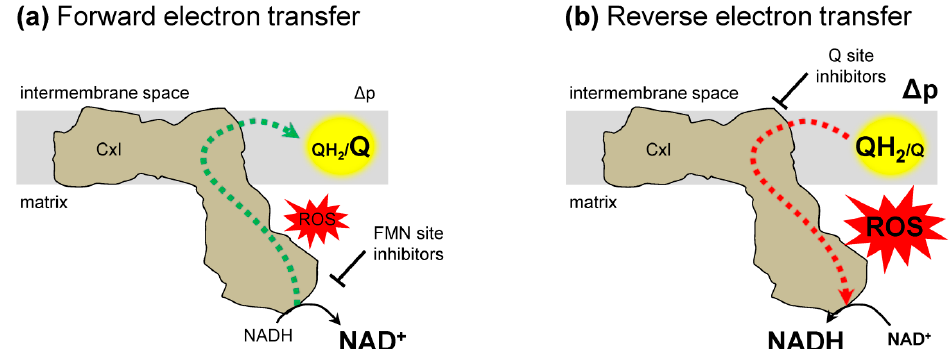
Figure 2. Complex I electron transfer. ( a ) Forward electron transfer. Electrons (dashed lines) are transferred from NADH to ubiquinone (Q) resulting in ubiquinol (QH 2 ). These conditions can generate reactive oxygen species (ROS). The addition of FMN site inhibitors prevent, while Q binding site inhibitors enhance complex I forward electron transfer generated ROS. ( b ) Reverse electron transfer (RET). Electrons from ubiquinol (QH 2 ) are transferred to NAD + and generate ROS. Both Q binding site and FMN binding site inhibitors suppress RET generated ROS. Δ p, protonmotive force; FMN, flavin mononucleotide.